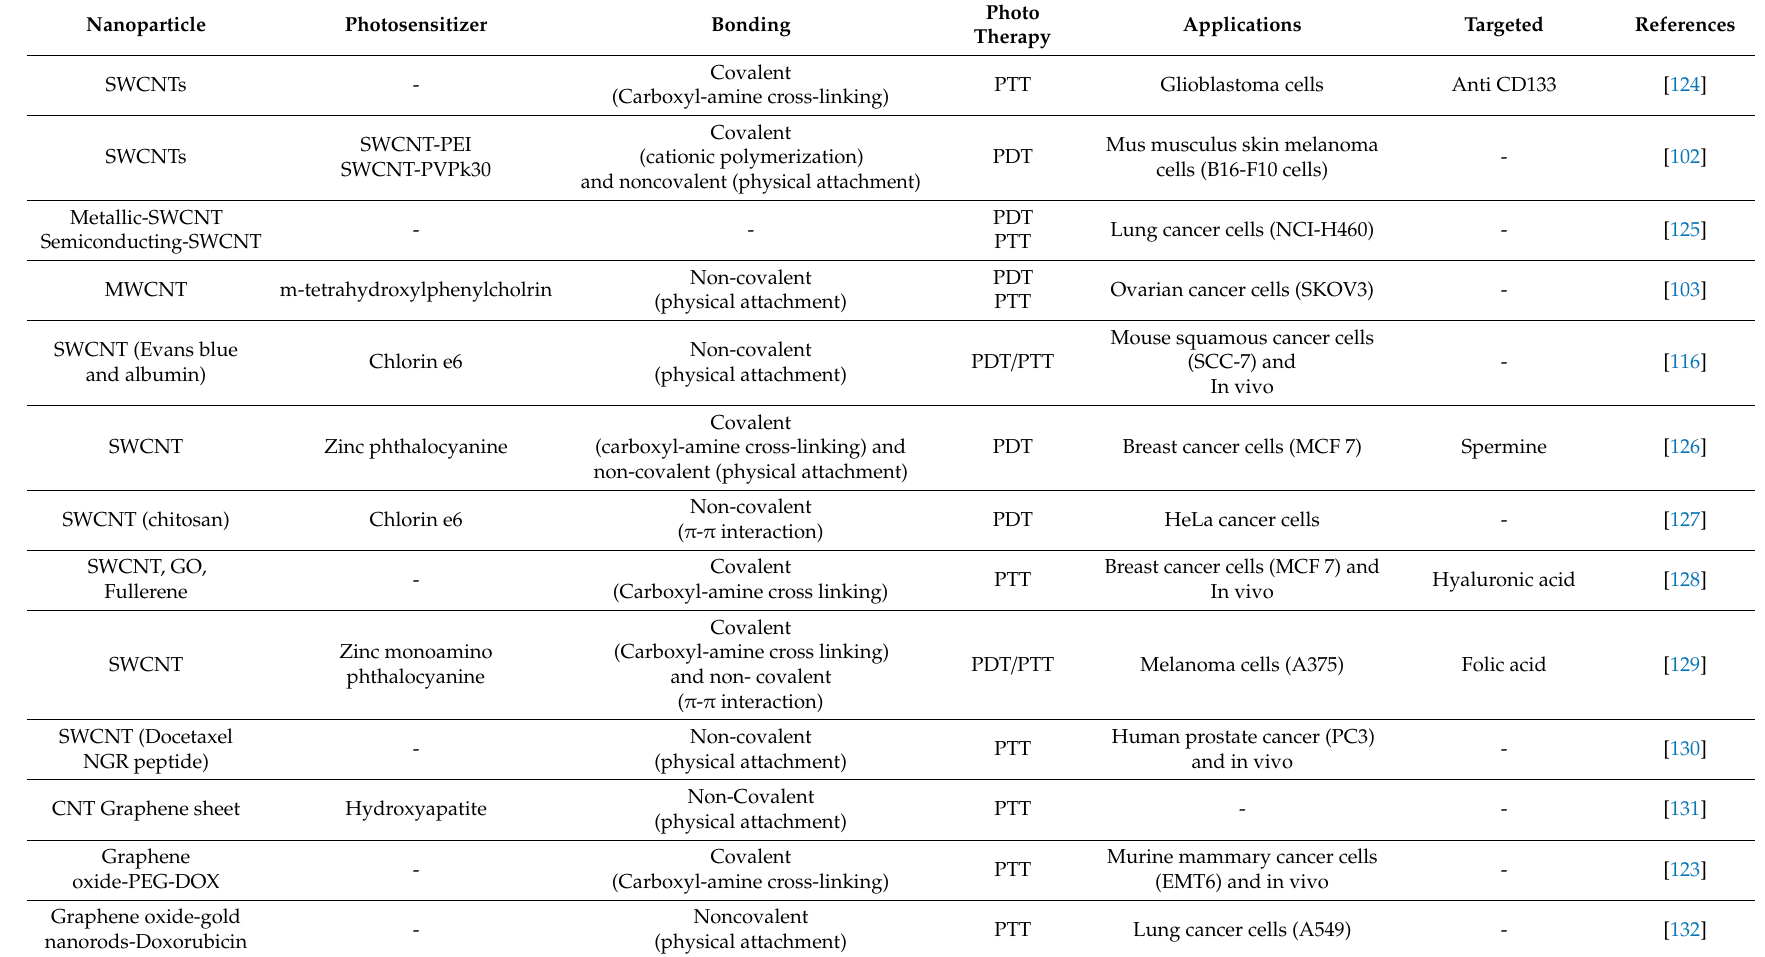
Table 3. Various applications of phototherapy using 1D and 2D carbon nanomaterials on